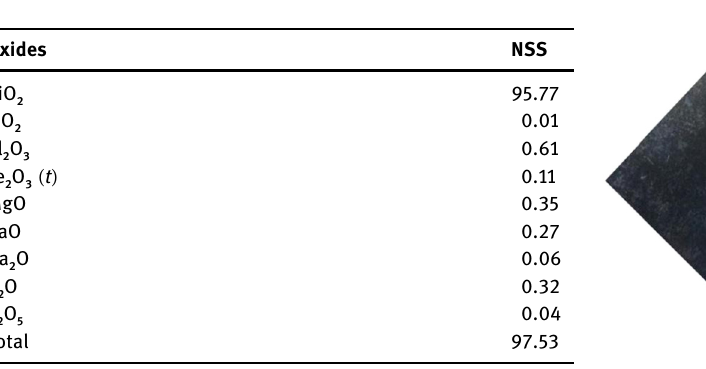
Table 1: The chemical composition of NSS ( wt% )